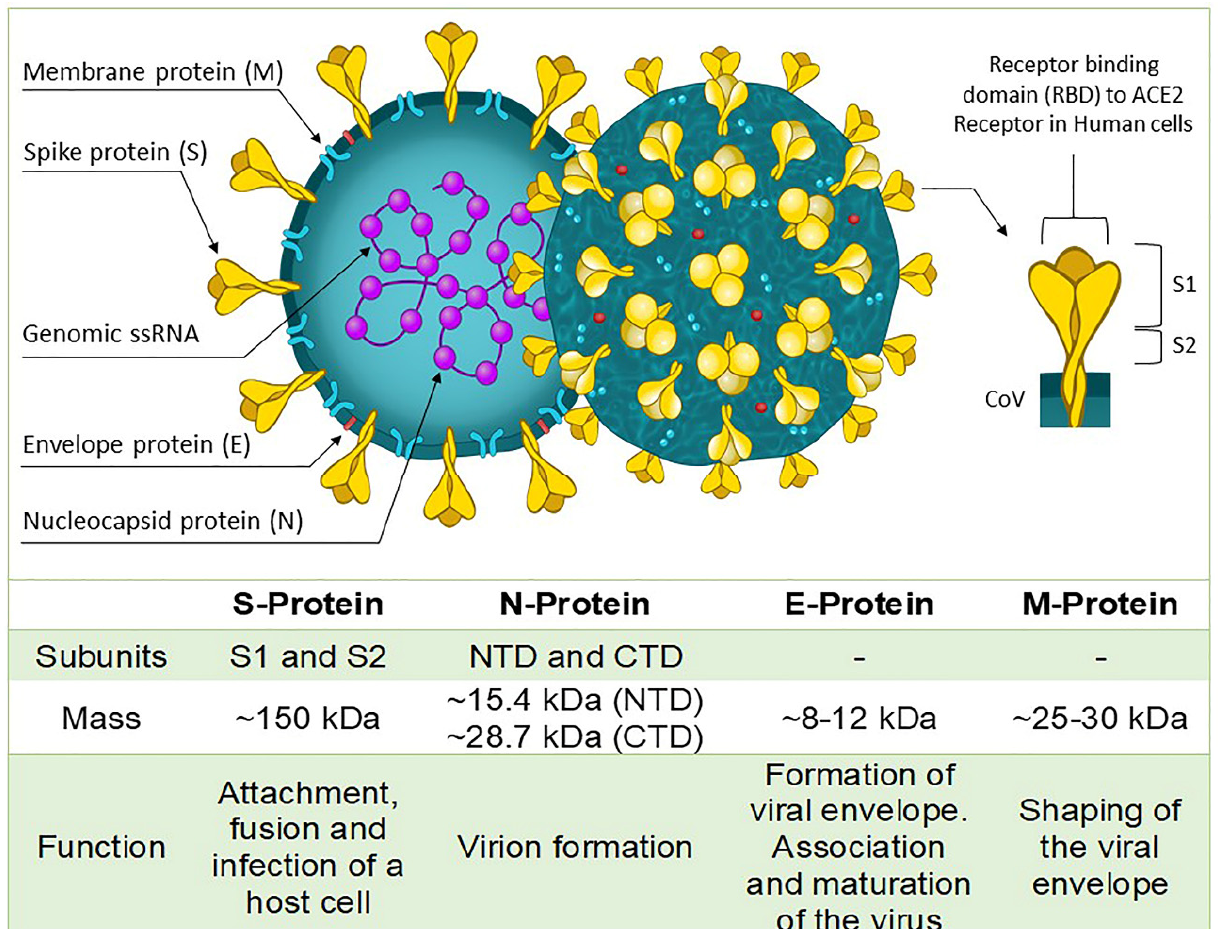
Figure 1. Typical structure of SARS-CoV-2 viral particle.